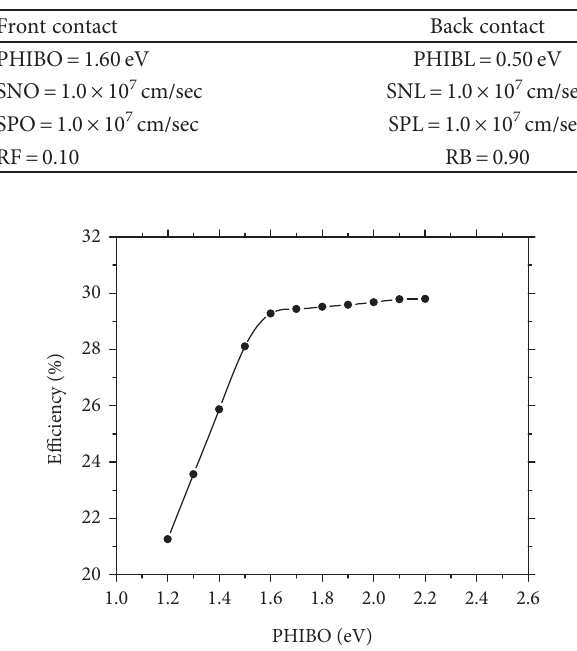
Table 5: Optimum values of the front and back contact parameters.